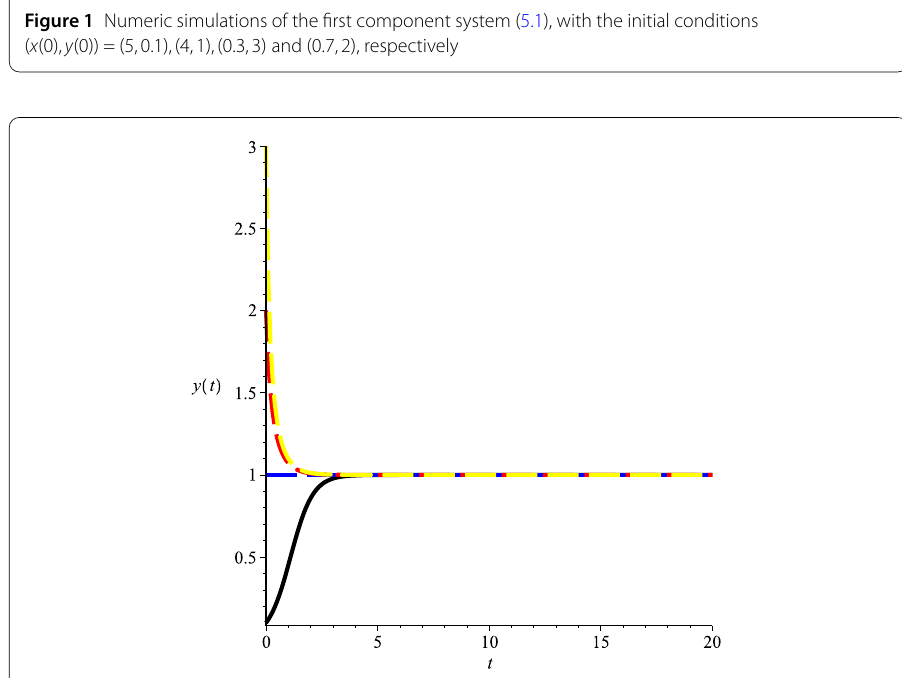
Figure 2 Numeric simulations of the second component of system (5.1), with the initial conditions ( x (0), y (0)) = (5,0.1),(4,1),(0.3,3) and (0.7,2),